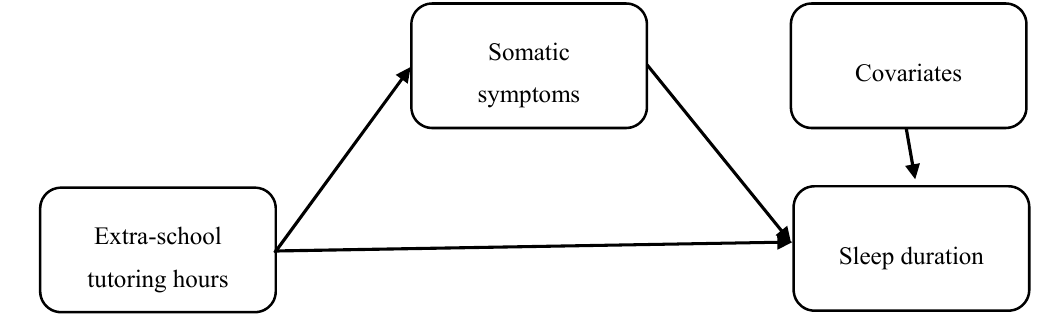
Figure 1. Illustration of the analysis model. Table 2. Multilevel structural equation model results: relationships between extra-school tutoring time, somatic symptoms, and sleep duration of adolescent students.